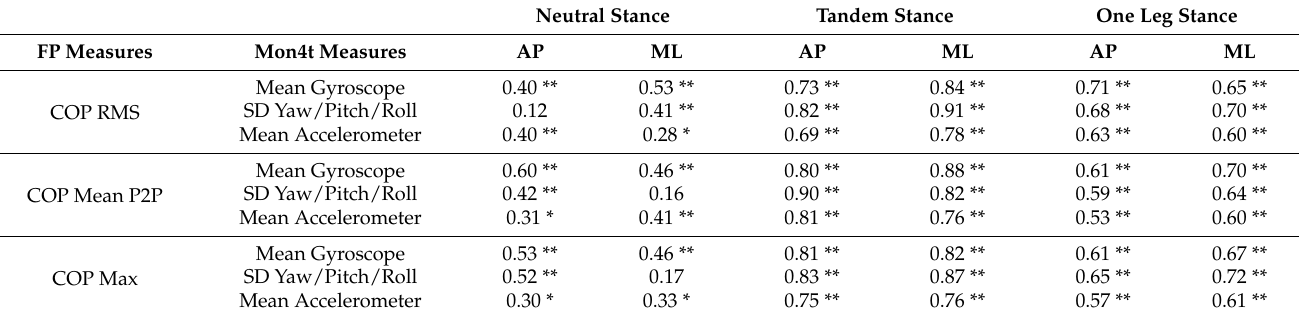
Table 1. Pearson correlation coefficients between force plate (FP) and smartphone, within static sway endpoints. Three metrics were applied to the center of pressure (COP) to extract 6 sway endpoints from the FP (for the AP and ML directions). Smartphone sway endpoints were obtained from 3 types of sensors (accelerometer, gyroscope, and orientation angle). Pearson correlations presented with their obtained p values, * p ≤ 0.05, ** p < 0.01.; RMS = root mean square; AP = anteroposterior; ML = mediolateral. Neutral Stance Tandem Stance One Leg Stance FP Measures Mon4t Measures One Leg Stance Mean COP RMS